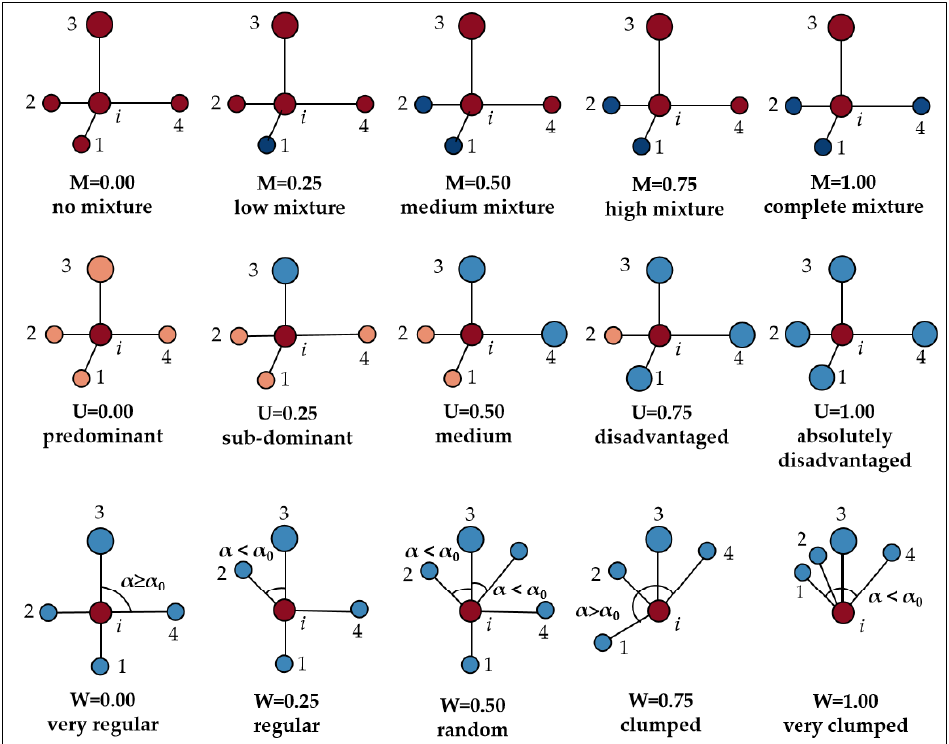
Figure 3. Indices of stand structure ( M , U, and W ) using nearest-neighbors spatial relationships based on a 5-tree group. Each tree i has a unique M i U i , W i that takes one of the following values: 0.00,0.25,0.50,0.75,1.00. Table 4. Indicators of spatial and non-spatial structural parameters of forest stands [25,26].